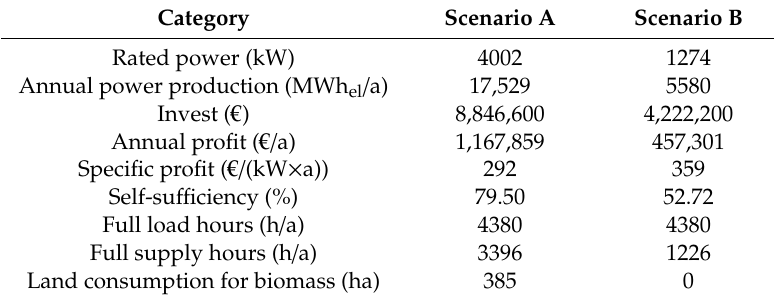
Table 1. Scenario